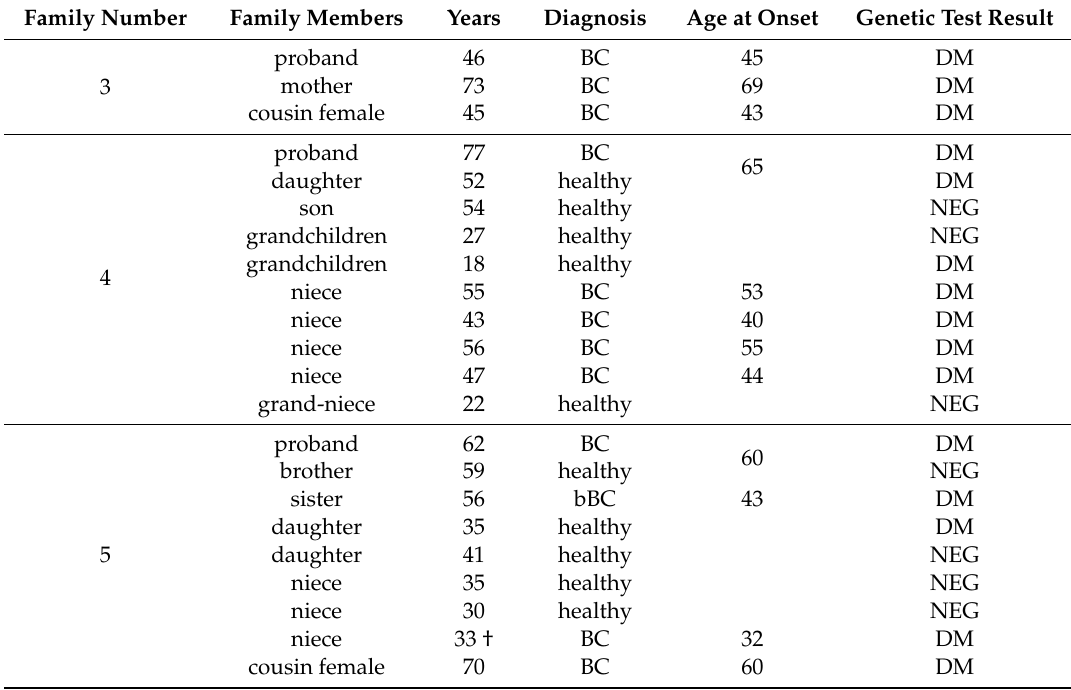
Table 4. Families tested for DM in BRCA2.